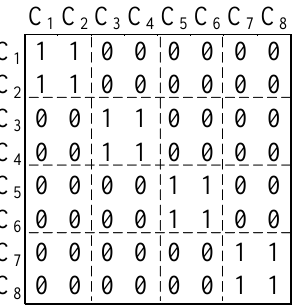
CC S CC S ] . 1 kji k 1 1 kji